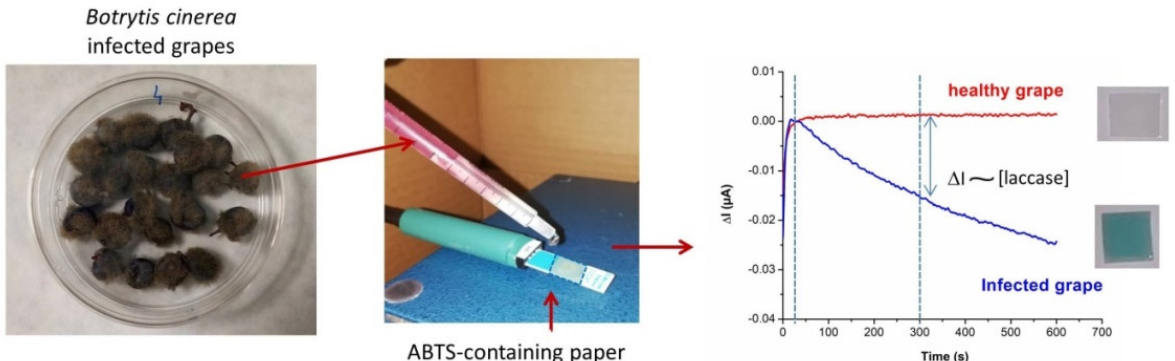
Figure 1. Principle of the assay for measuring the laccase activity of grape musts. The must from Botrytis cinerea infected grapes is pushed through a PVPP cartridge and a drop of the filtered sample is placed on an ABTS-impregnated paper on top of a screen-printed electrode system. The ABTS oxidized by the laccase from the infected grapes has a green-blue color, easily observable with the paper sensor. At the same time, the current due to the electrochemical reduction of the oxidized ABTS at 0 V is quantitatively correlated with laccase activity.